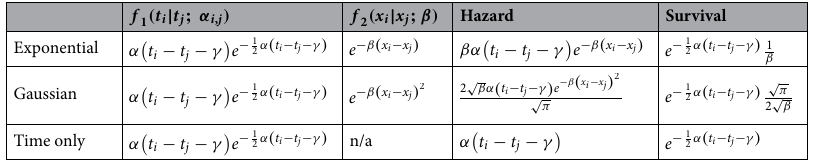
Table 6. Equations for f1, f2, hazard and survival for time-only, Gaussian and Exponential spatial